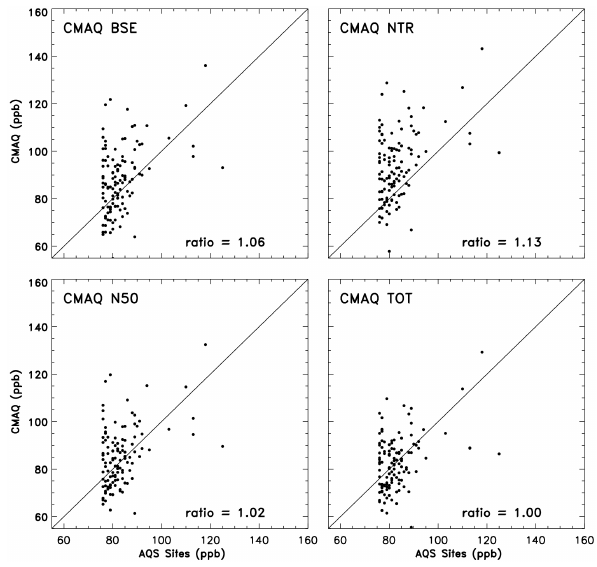
Figure 10. Comparison of average 8h surface ozone calculated from baseline CMAQ model output (top left), CMAQ NTR model output (top right), CMAQ N50 model output (bottom left panel), and CMAQ TOT (bottom right) to observations from ground-based AQS sites for those days and locations in Maryland that experienced ex- ceedances (8h average ozone greater than 75ppb) during July and August